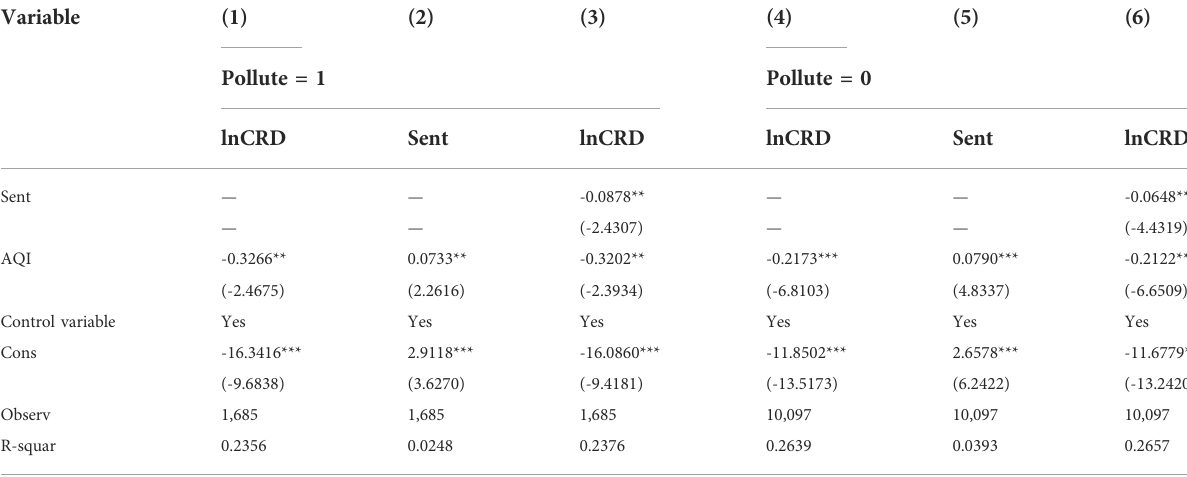
TABLE 10 Heterogeneity analysis of polluting enterprises based on investor sentiment. Variable